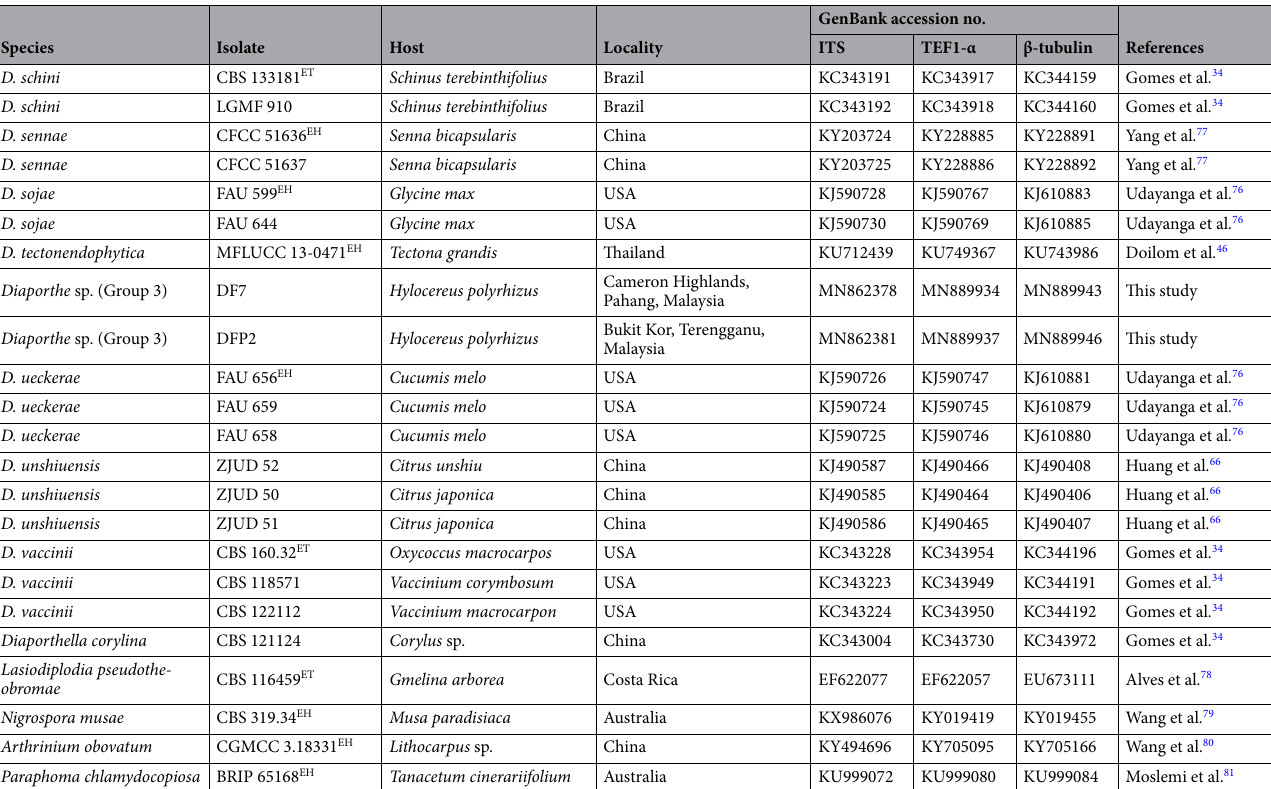
Table 3. Isolates in the present study and reference isolates used in the phylogenetic analysis. EP ex-epitype culture, EI ex-isotype culture, ET ex-type culture, EN ex-neotype culture, EH ex-holotype